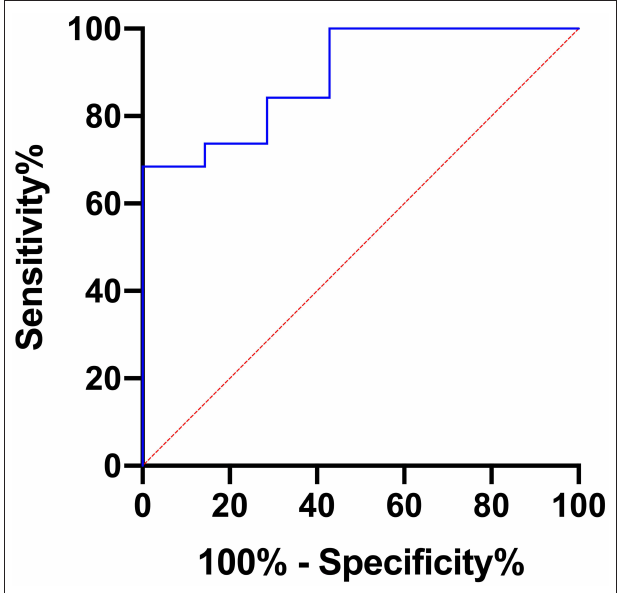
FIGURE 3 | Provides the receiver operating characteristics (ROC) curve of ADCmax, the parameter with the best accuracy in terms of differentiating grade I and grade II